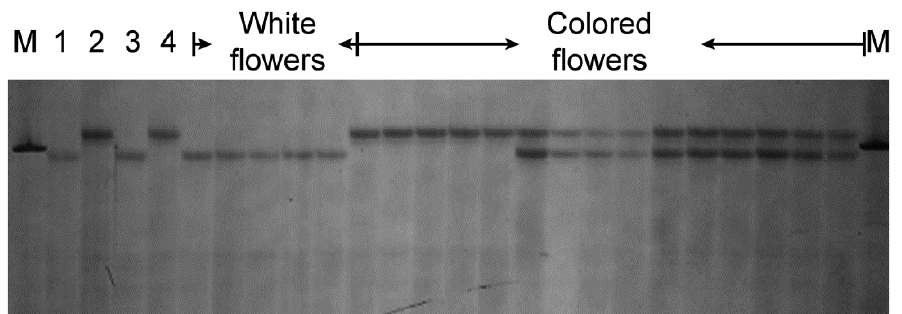
Figure 2. PCR amplification results of the SSR marker SSR 84 in part of the F 2 population segregating for zt-1 . 1, M3290 (900 bp); 2, Qinghai12 (1100 bp); 3, white flower bulk (900 bp); 4, purple flower bulk (1100 bp); M, Marker (100 bp). The F 2 population includes 5 white flower genotypes (zz, 900 bp), 5 purple flower genotypes (ZZ, 1100 bp) and 10 heterozygous genotypes (Zz, 1100 bp); This is a composite picture of several different gel picture.